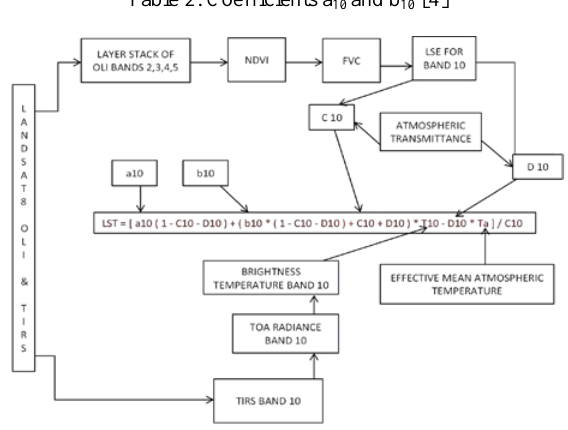
Table 2. Coefficients a 10 and b 10 [4]